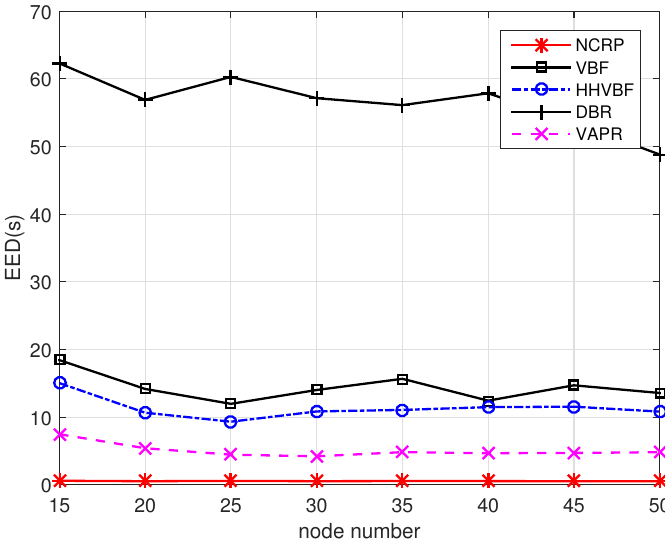
Figure 13. EED performance with varying node